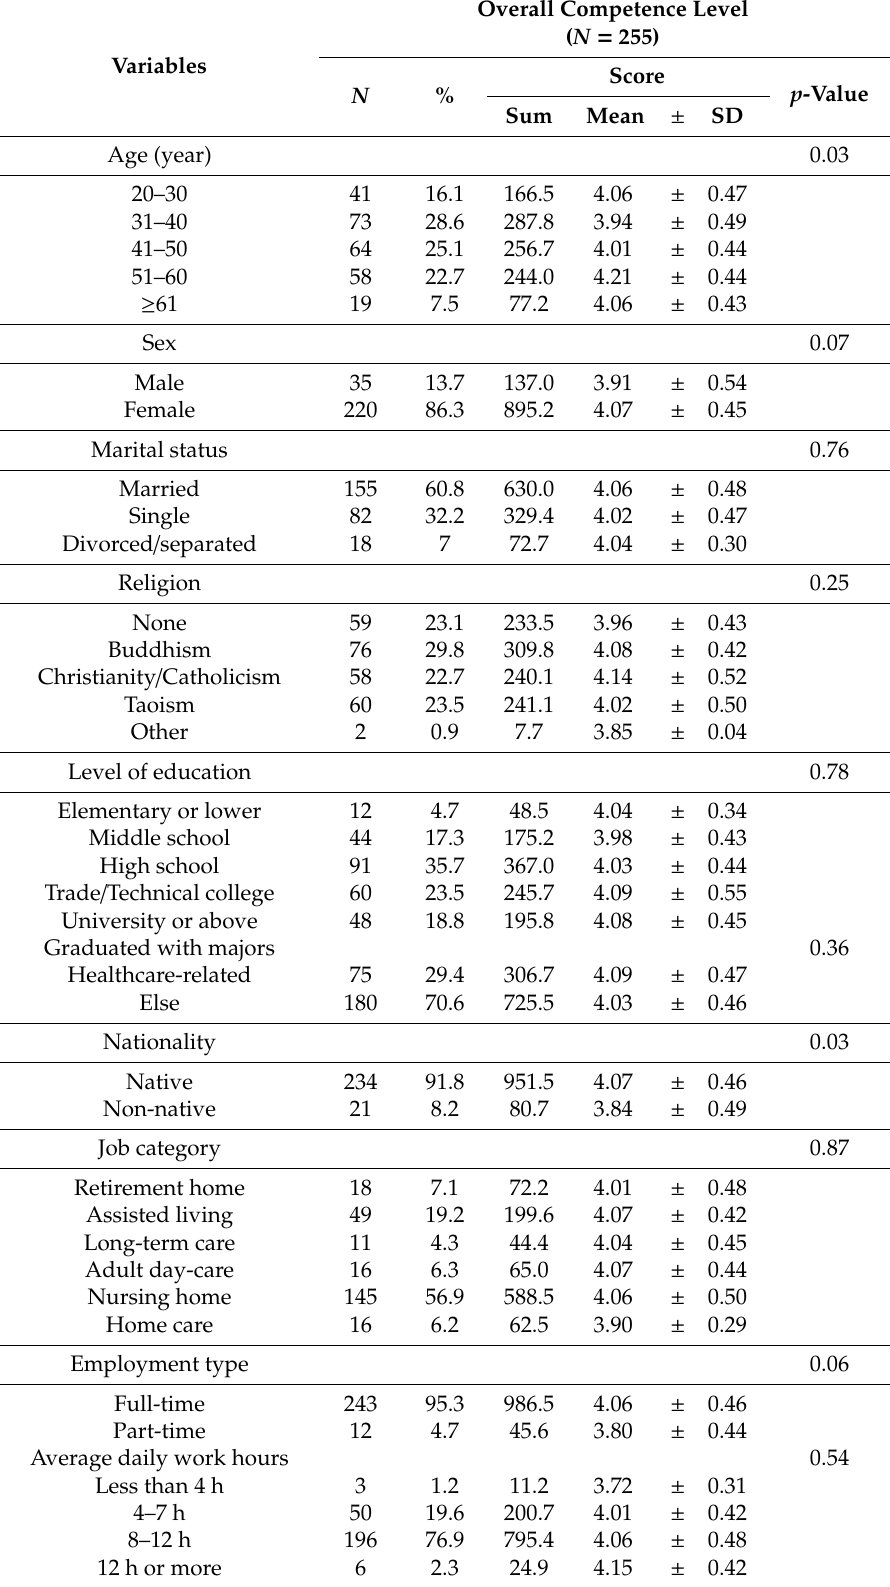
Table 1. The overall competence level of disability nursing